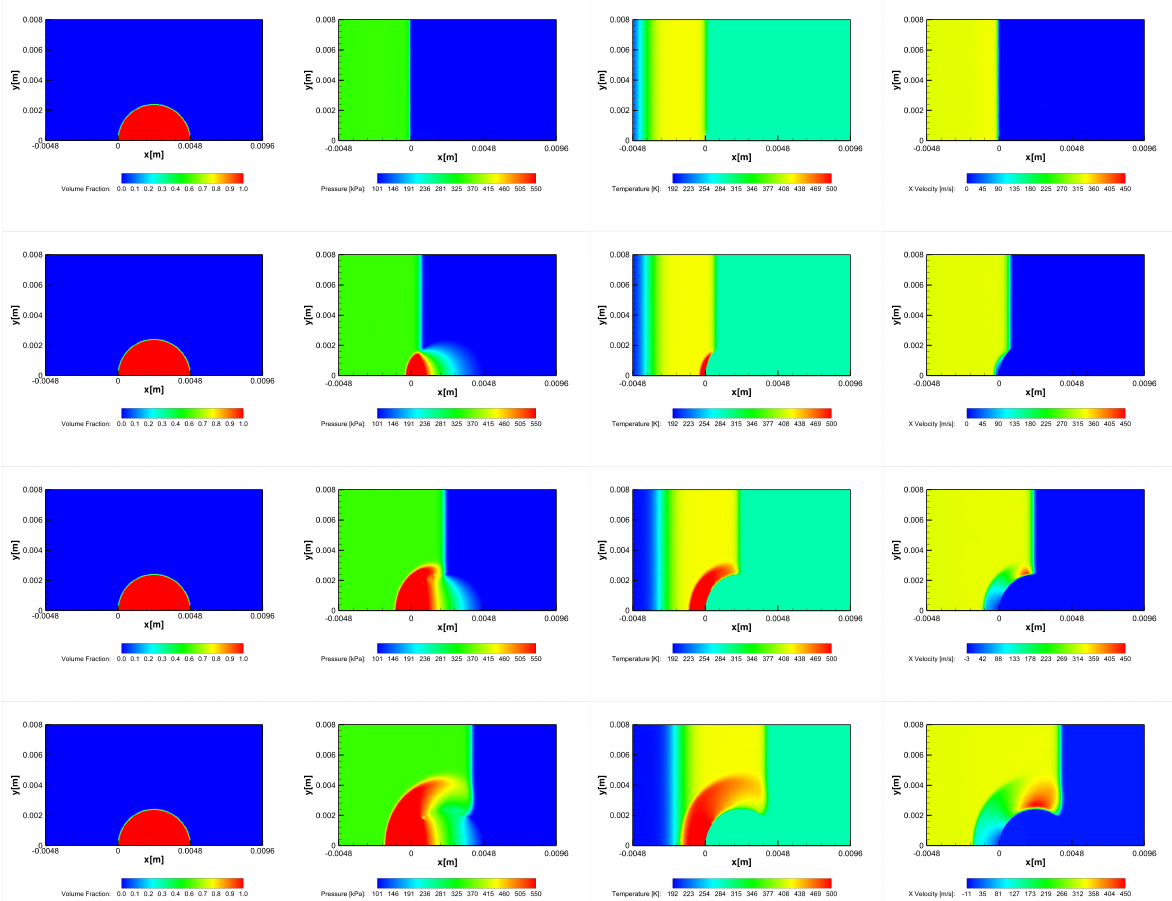
Figure 4. Contour maps for volume fraction of water, pressure, temperature, and streamwise velocity fields (from left to right ), corresponding to t ∗ = 0, 0.01, 0.016, and 0.03 (from top to bottom Figure 4. Instantaneous contours for volume fraction of water, pressure, temperature, and stream- wise velocity fields (from left to right), corresponding to t ∗ = 0, 0.01, 0.016 and 0.03 (from top to bottom).